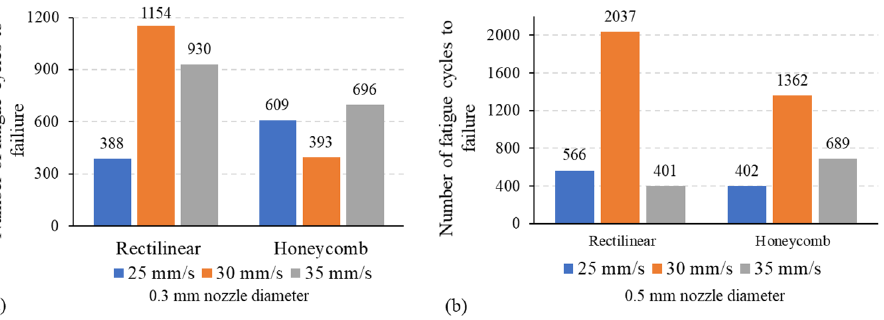
Figure 9. ABS fatigue life to failure sensitivity to printing speed with different infill patterns and nozzle diameters of ( a ) 0.3 mm and ( b ) 0.5 mm.